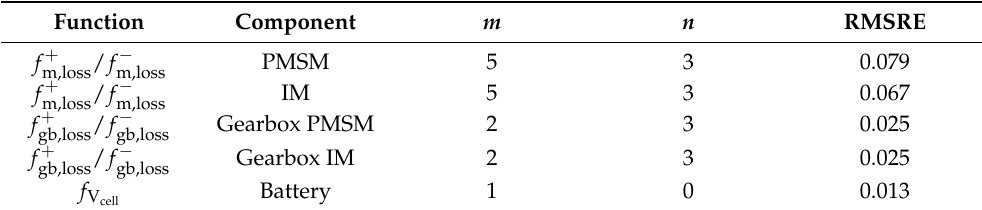
Table 1. Fitting parameters and results for the split meta-models. The parameters m and n represent the polynomial order (coefficients m and n of Equation (5)).